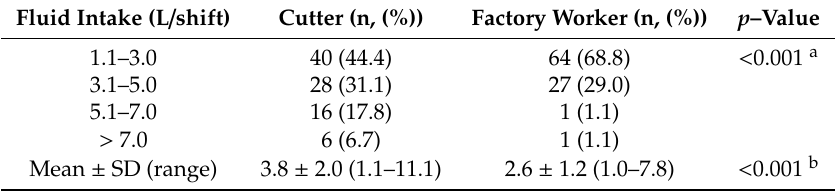
Table 2. Fluid intake per shift of sugarcane workers (90 cutters and 93 factory